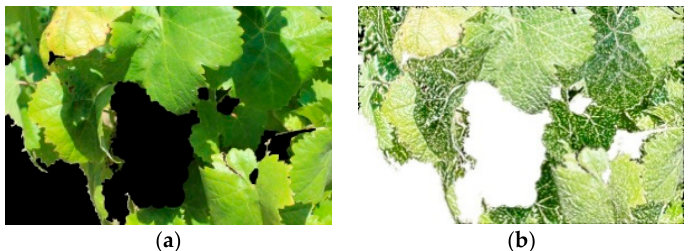
Figure 6. Gray morphology procedure: ( a ) A segmented leaf image; ( b ) Gray morphology output.